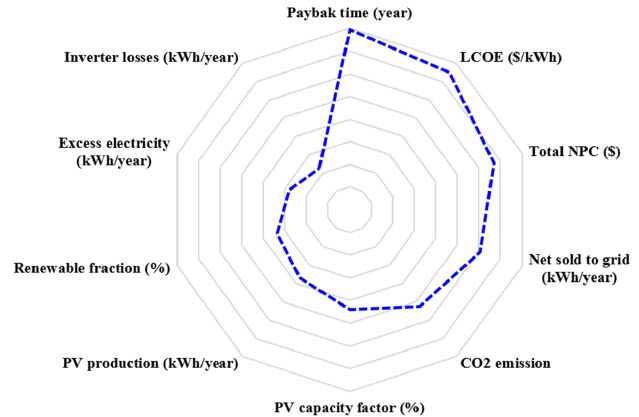
Figure 10. Comparing the criteria weights.